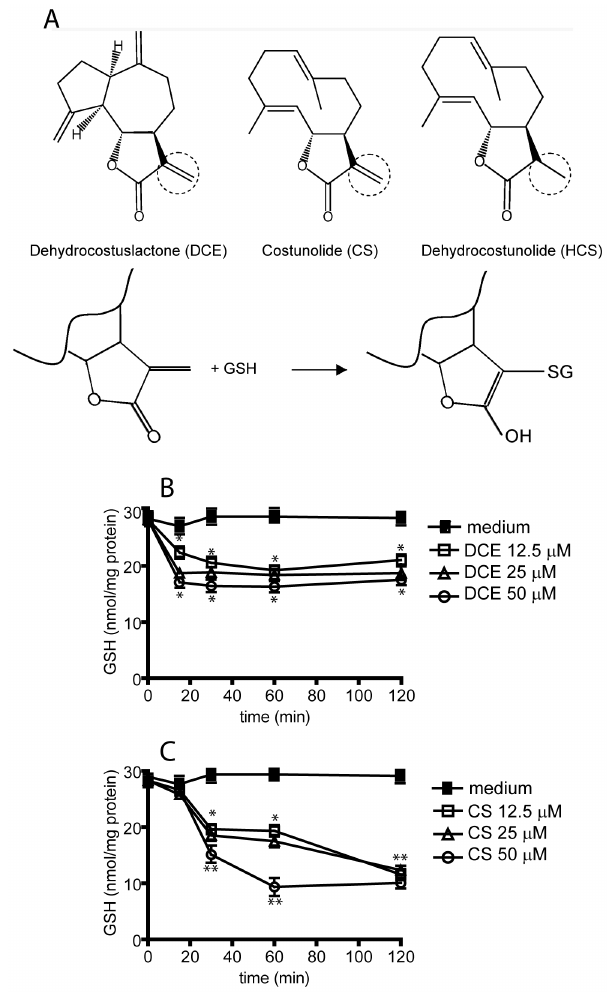
Figure 1. DCE and CS decrease intracellular GSH level in human keratinocytes. (A) Reaction scheme of GSH and CS or DCE interaction. DCE and CS, as well as other natural sesquiterpenes, have in common a reactive a - b -unsaturated carbonyl group that may react by a Michael-type addition with nucleophiles, such as cysteine sulfhydryl groups. DCE (B) and CS (C) time- and dose-dependently induce the drop in cellular GSH content measured by spectrophotometric analysis. Treatment of cultures with culture medium alone do not vary GSH release. Data are presented as means of GSH content 6 SD of results of four independent experiments. Terpene-treated groups were compared to untreated groups (time 0). * p # 0.01 and ** p # 0.05.